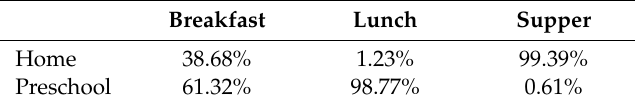
Table 3. Eating locations of